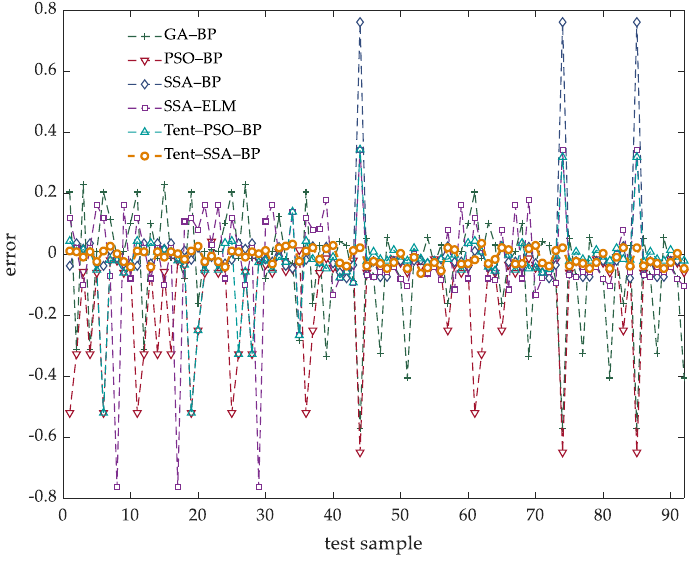
Figure 9. Prediction error curve. Table 5. Prediction accuracy of different methods under different noise